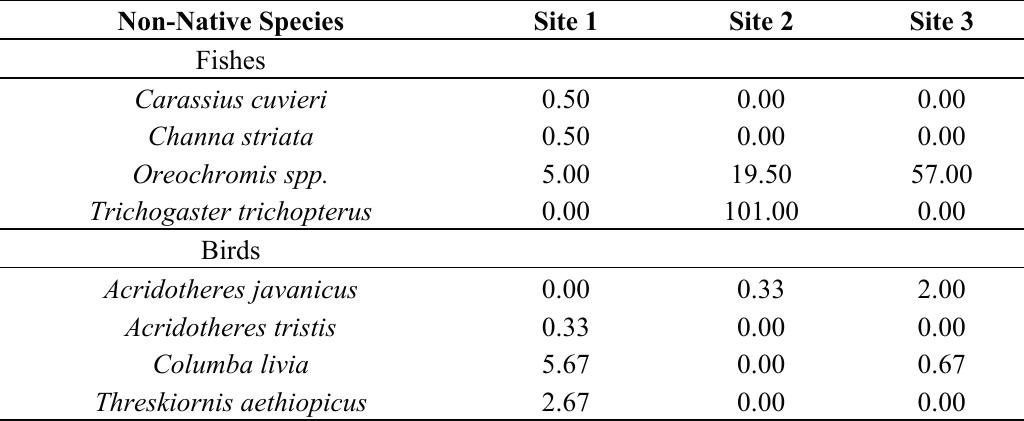
Table 3. Abundance of the dominant non-native fish and bird species in the three study urbanized